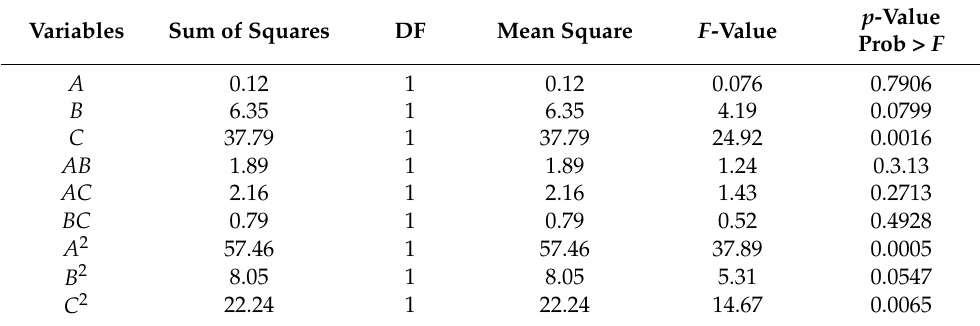
Table 4. Estimated regression model of relationship between response variable (yield of crude polysaccharide) and independent variables ( A , B , and C